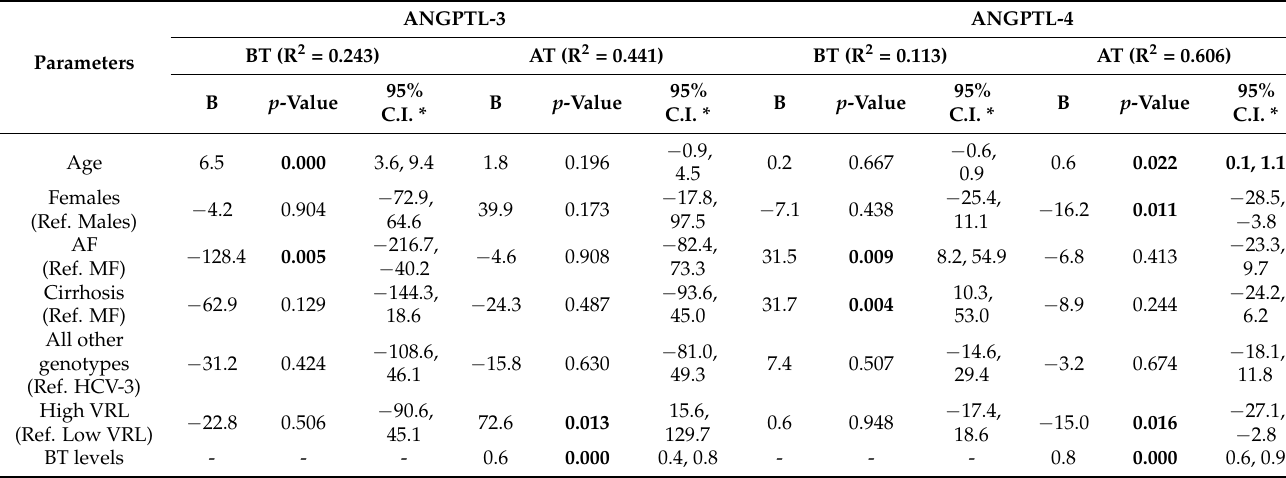
Table 6. Identification of independent parameters that may influence ANGPTL-3 and ANGPTL-4 serum levels before and after viral eradication by multiple linear regression